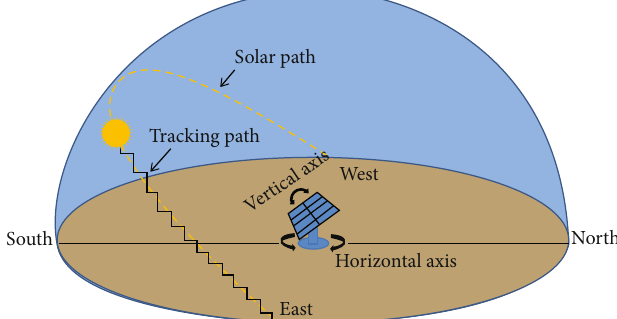
Figure 6: The cascading path of the azimuthal solar tracker movement.